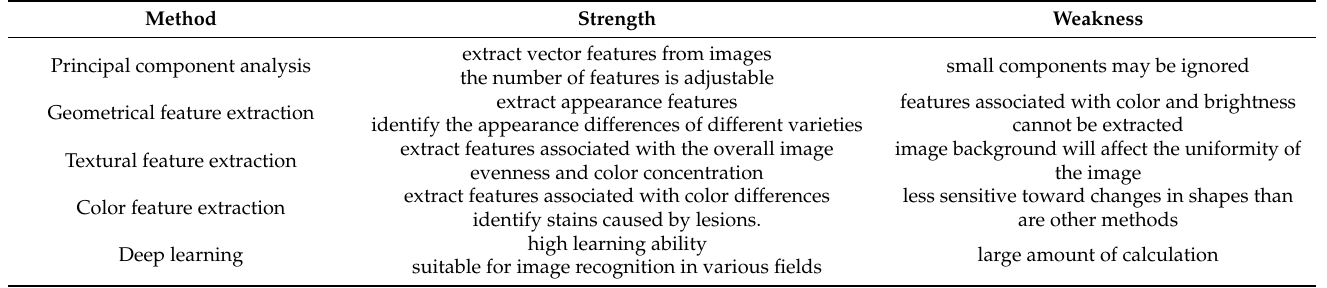
Table 1. Comparison of different feature extraction